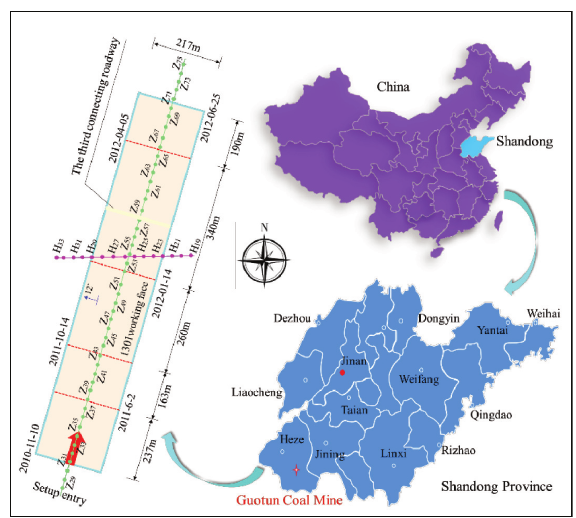
Figure 5: The location of 1301 working face.